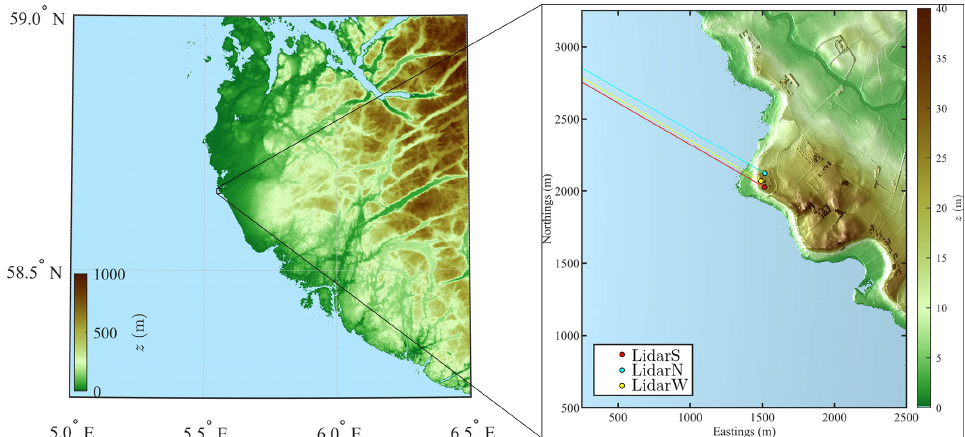
Figure 1. Location of the Obrestad Lighthouse on the southwest coast of Norway with a sketch of the three Doppler wind lidars named LidarS, LidarN and LidarW pointing toward a direction of 300 ◦ .